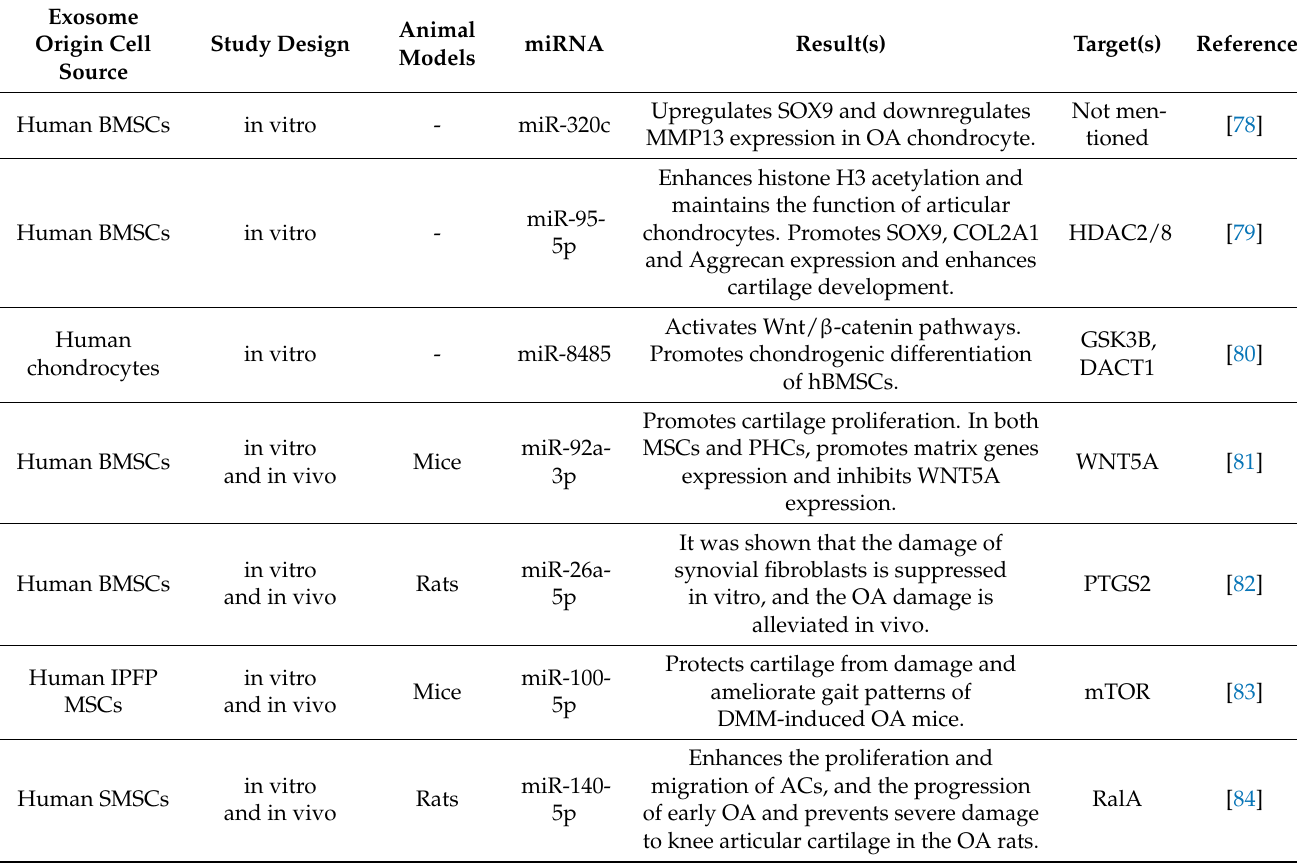
Table 1. Studies on exosomal miRNAs regulating chondrocyte function and homeostasis for the purpose of intra- articular